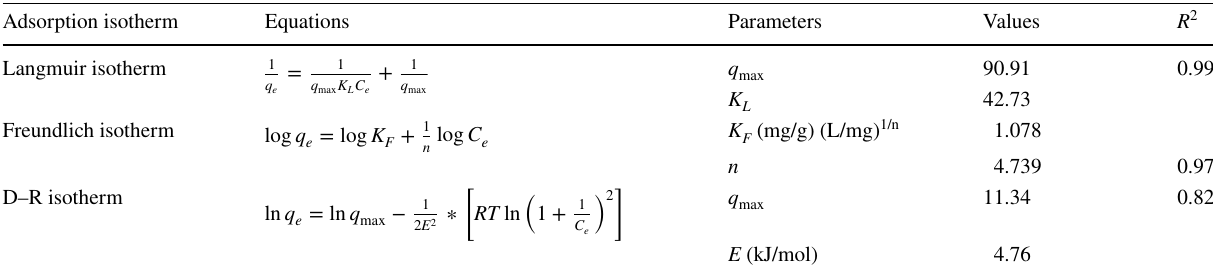
Table 1 Isotherm data for Cr(VI) adsorption using chicken